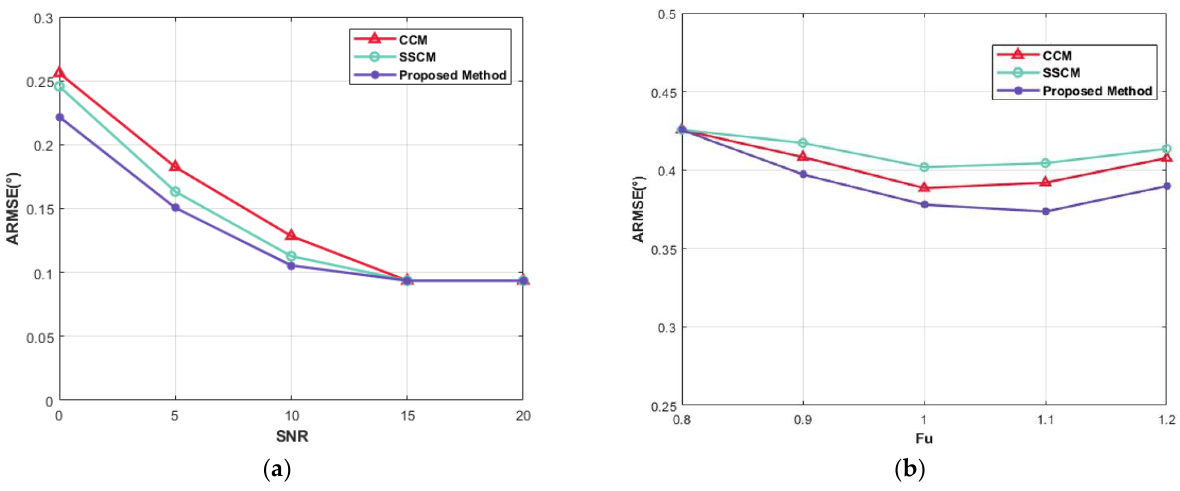
Figure 7. ( a ) ARMSEs of phase bias estimates versus SNR: CCM (red), SSCM (green), the proposed approach (purple). ( b ) ARMSEs of phase bias estimates versus channel uniformity: CCM (red), SSCM (green), the proposed approach (purple).